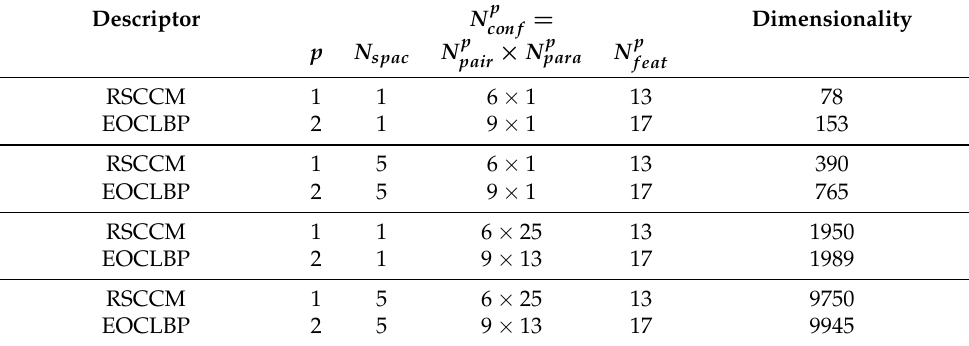
Table 1. Dimensionality of color texture feature